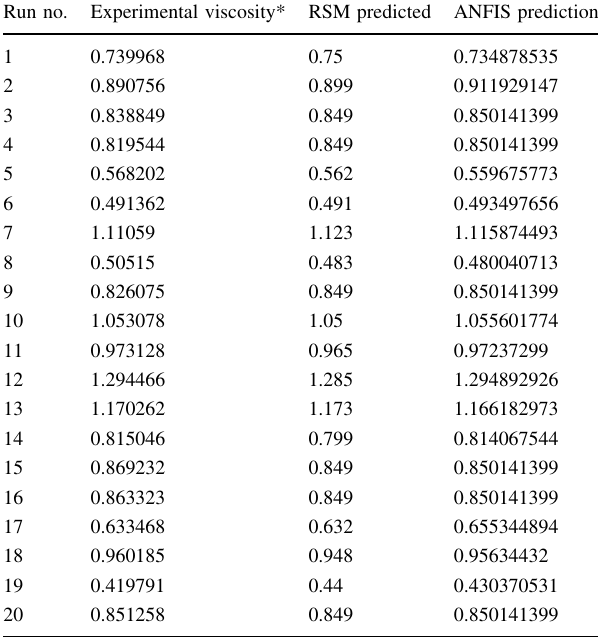
Table 5 The experimentally obtained viscosity of polymer solution compared to that predicted by the associated RMS and ANFIS